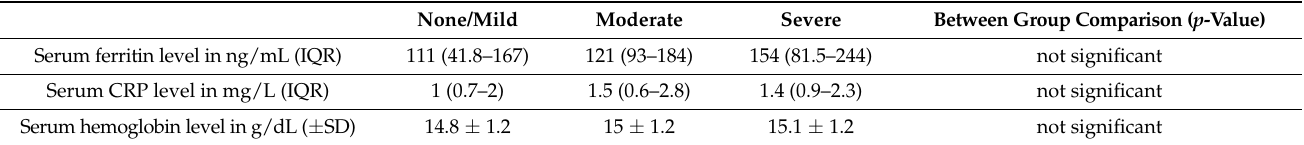
Table 3. Comparison of ferritin, C-reactive protein, and hemoglobin serum levels among the three di ff erent patient groups.